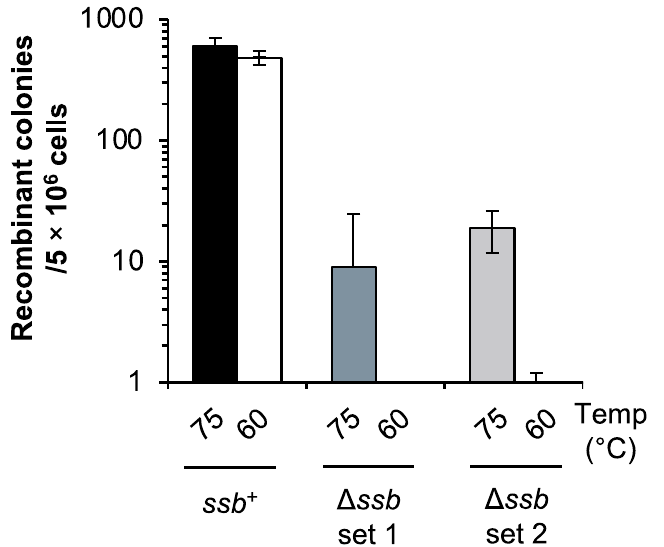
Figure 1. HR frequency in the ssb -deleted strain through the mating test. Recombinant colonies resulted from mating of uracil-auxotrophic strains. Recombination between two strains successfully restored the uracil-proficient phenotype. Numbers 75 and 60 indicate the cultivation temperature ( ◦ C) before mating. Mating was performed as follows: Ssb + , DP-1 and DP-2. ∆ ssb set 1; DP-5 and DP-11-1. ∆ ssb set 2; DP-5 and DP-11-3. Error bars represent ±SD calculated using three biological replicates.